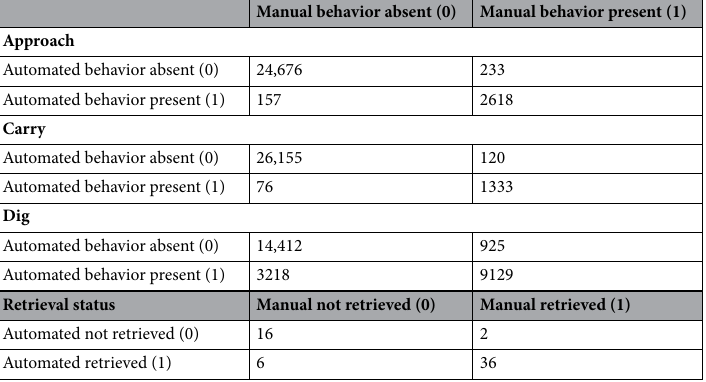
Table 2. Confusion matrices of manual and automated classification of retrieval status and maternal approach, carry and digging